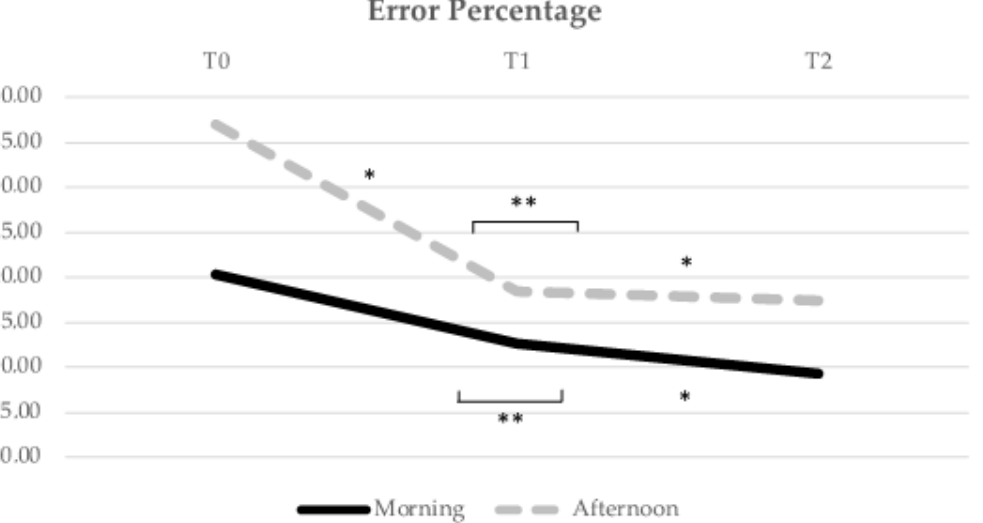
Figure 4. Evolution of the Error Percentage mean score over time (from T0 to T1, i.e., from pre- to post-acute exercise; and from T1 to T2, i.e., from post-acute exercise to post-chronic exercise). * Indicates significant differences for p < 0.05; ** Indicates significant differences for p <